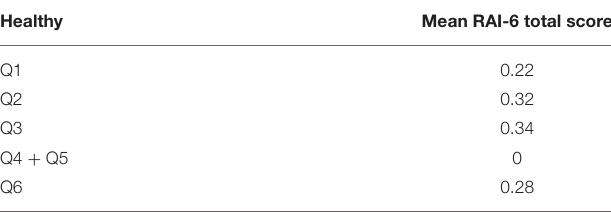
TABLE 7 | Mean RAI-6 scores in healthy participants.